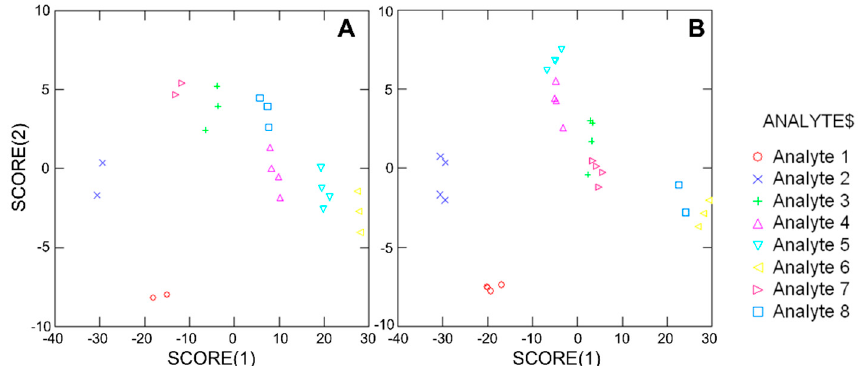
Figure 9. Linear discriminant analysis of fluorescence response patterns of analytes 1 – 8 with fluorophore 9 in Kingston snow, with ( A ) β -cyclodextrin and methyl- β -cyclodextrin as predictors, as well as ( B ) β -cyclodextrin and phosphate-buffered saline as predictors.